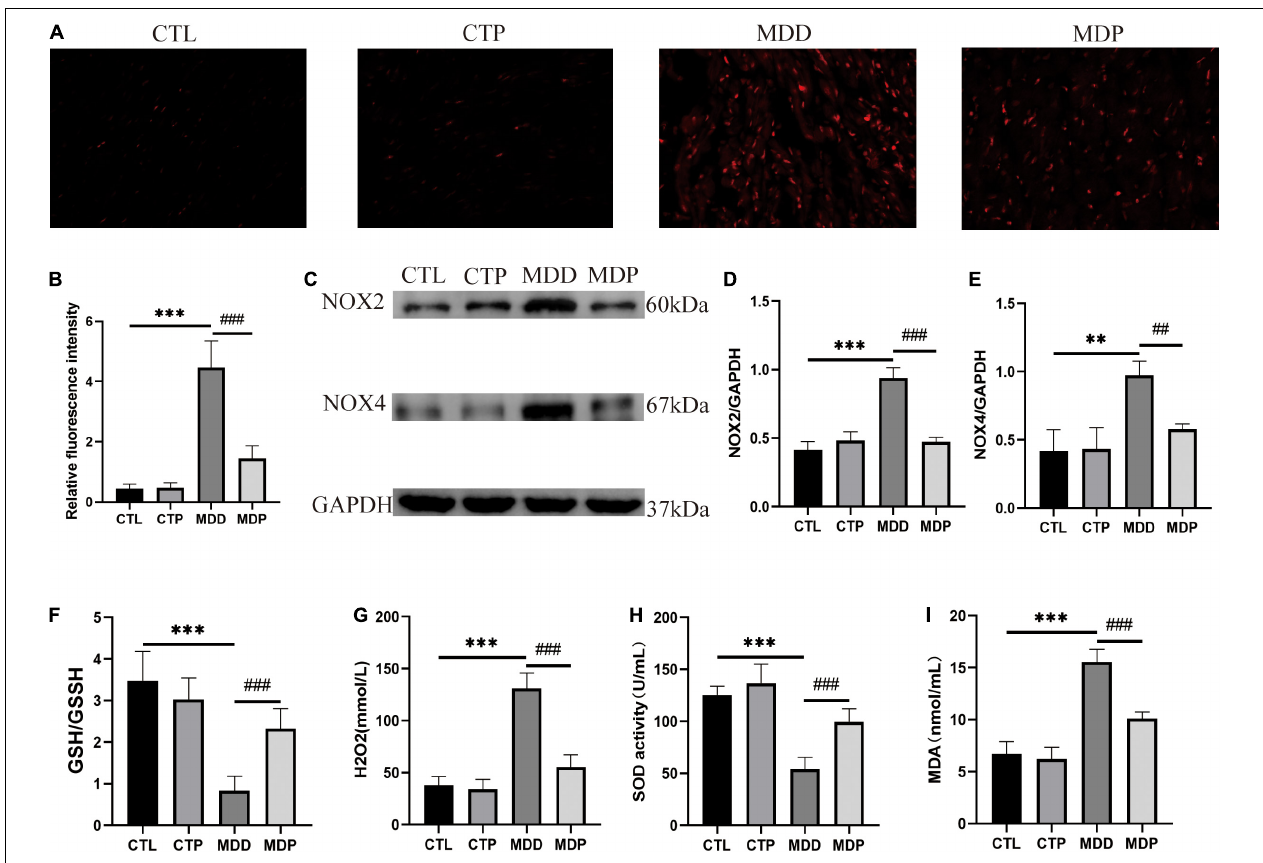
FIGURE 8 | Oxidative stress. (A) Typical images of ROS. (B) Relative fluorescence intensity of ROS, n = 6 per group. (C) Immunoblotting of NOX2 and NOX4. (D,E) Quantitative analysis of NOX2 and NOX4, n = 5 per group. (F–I) GSH/GSSG, the concentration of H2O2, the activity of SOD, and the concentration of MDA in serum, n = 7 per group. ** p < 0.01, *** p < 0.001 vs. CTL; ## p < 0.01, ### p < 0.001 vs.